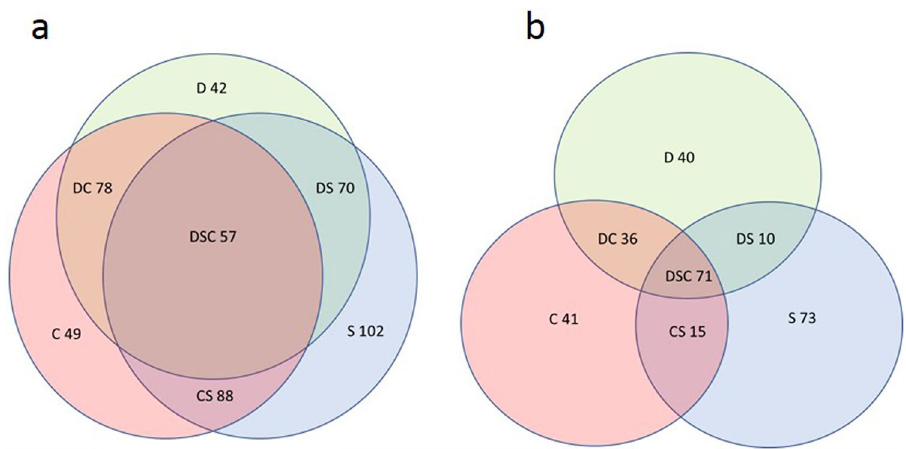
Figure 3. Venn diagram of the number of unique and common OTUs in bacterial ( a ) and fungal ( b ) soil